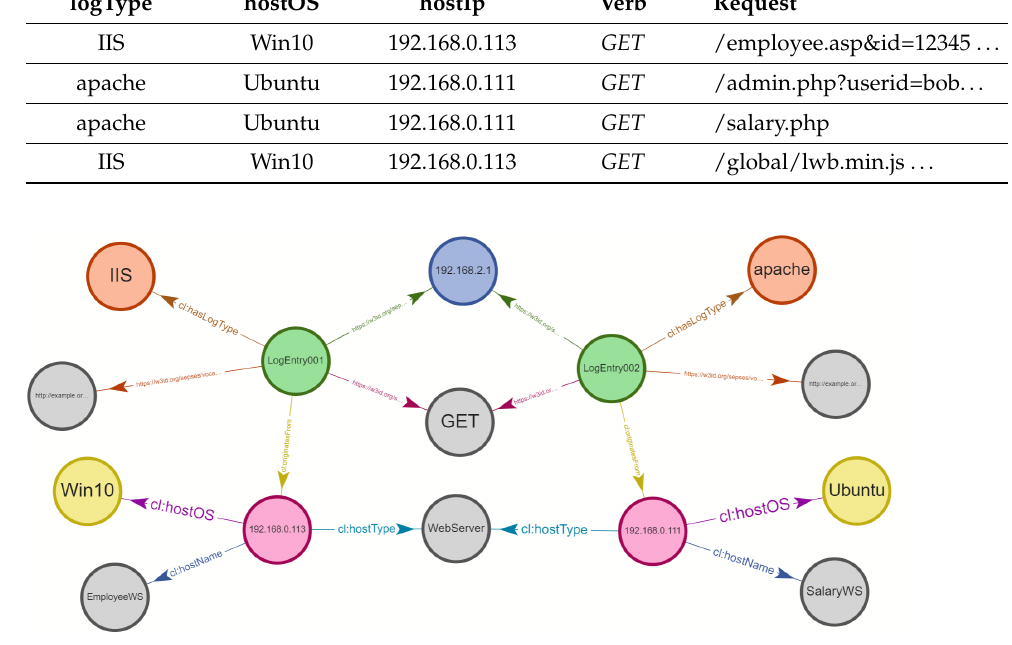
Figure 8. Web access query result visualization